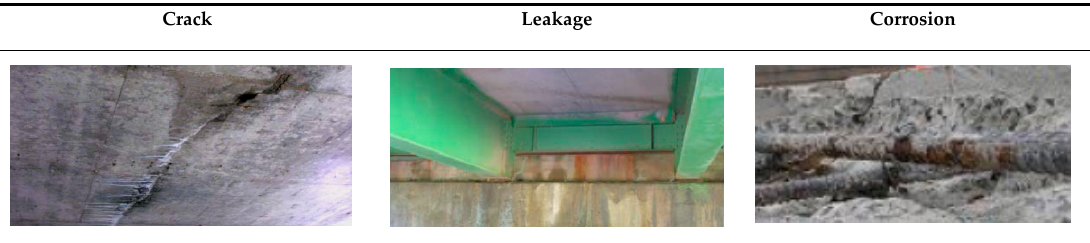
Figure 2. Some of the different types of damage of bridges (Used with permission by Iowa DOT) [7]